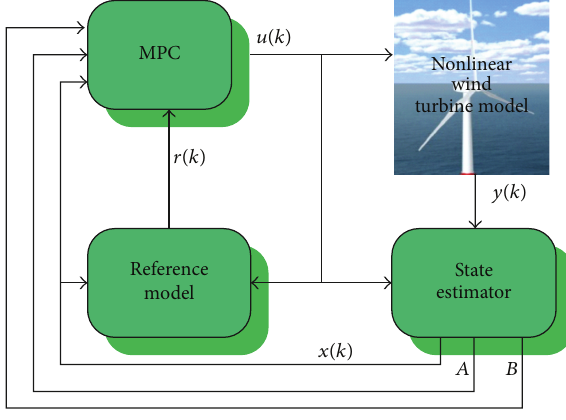
Figure 2: Wave disturbance using MPC.